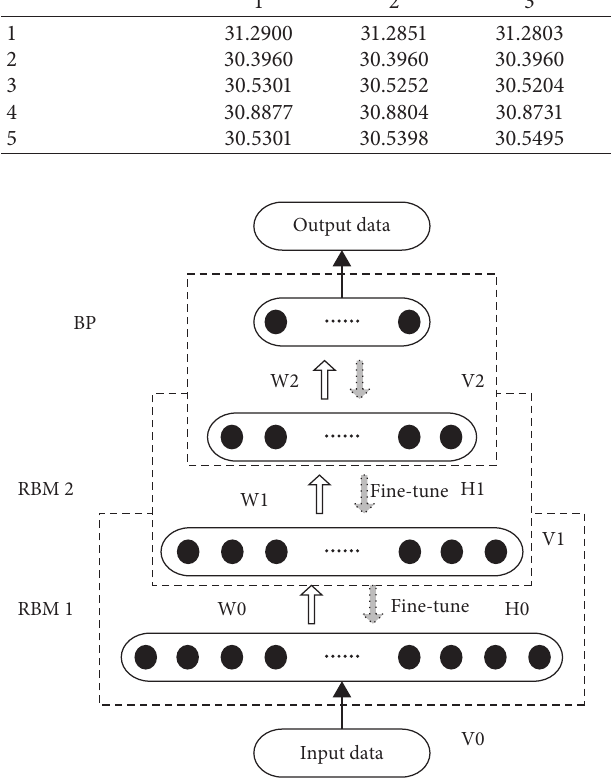
Figure 5: The structure of deep learning neural network based on RBM.